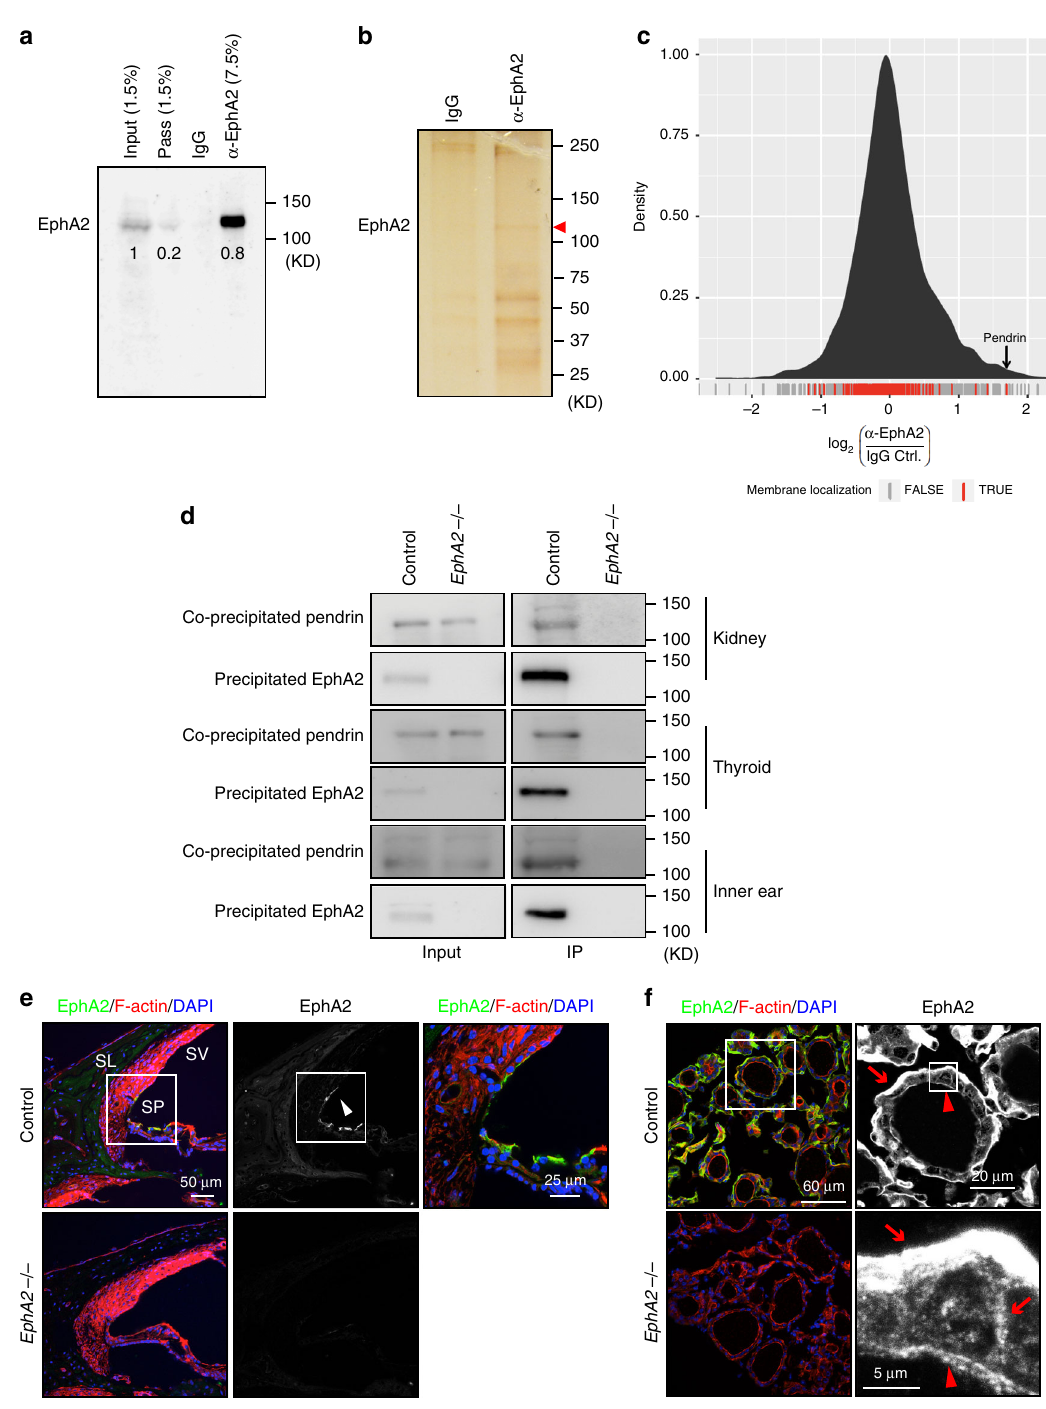
Fig. 1 Identi fi cation of pendrin as an interacting protein of EphA2. a , b Immunoprecipitation of EphA2 from kidney lysate. Speci fi c precipitation of EphA2 was con fi rmed by western blotting analysis ( a ) and by silver staining ( b ) of precipitated protein compared to IgG control. Indicated numbers in a represent relative amount of precipitated EphA2 and EphA2 passed thorough immunoprecipitation compared to input (pass). c Identi fi cation of pendrin by label free quanti fi cation in mass spectrometry-based protomics analysis of EphA2 immunoprecipitate as compared to IgG control. Pendrin is the protein with the highest enrichment among membrane localized proteins. The ratio distribution of proteins identi fi ed is shown as a kernel density estimate. Localization of transmembrane proteins in the distribution is indicated red in the rug. d Con fi rmation of the protein complex by immunoprecipitation using an anti-EphA2 antibody. Precipitated proteins from the kidney, the thyroid and the inner ear from control and EphA2 KO mice were analyzed by western blotting analysis with the EphA2 and the anti-pendrin antibodies respectively. e Immunostaining of the inner ear using anti-EphA2 speci fi c antibody (green or gray, arrowhead) with phalloidin (red, F-actin) and DAPI (blue, nucleus). The speci fi city of the signal against EphA2 was con fi rmed in the EphA2 KO inner ear. SL spiral ligament, SV stria vascularis, SP spiral prominence. f Immunostaining of the thyroid using anti-EphA2 speci fi c antibody (green) with phalloidin (red, F-actin) and DAPI (blue, nucleus). The speci fi c signal of EphA2 was con fi rmed in the EphA2 KO thyroid. The strong signal of EphA2 was observed at basal membrane (arrow). Although the signal is weak, EphA2 expression was also con fi rmed at apical surface (arrowhead). Source data are provided as a Source Data fi